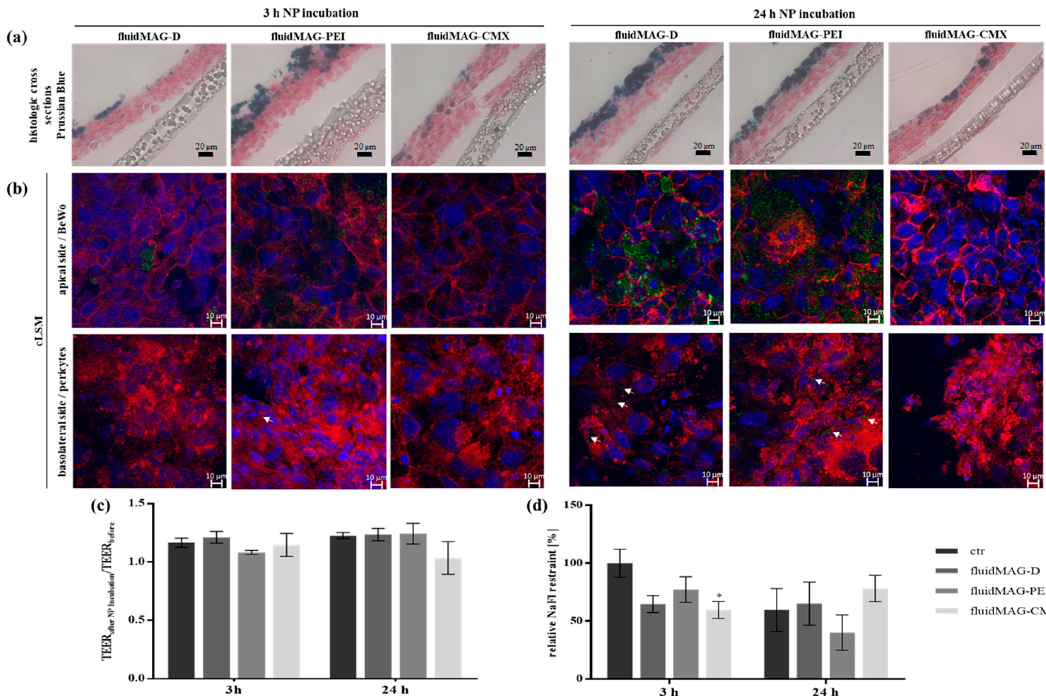
Figure 2. Analysis of the barrier integrity and morphology of the transwell co-culture BPB model after exposure to different SPIONs for 3 h or 24 h. For the co-culture model, 1.1 × 10 6 cells cm − 2 of pericytes were seeded onto the basolateral side of 24-well membrane inserts and 6.1 × 10 5 cells cm − 2 of BeWo cells were seeded on the apical side of the insert membrane after 24 h. On day four post seeding (PS), barrier models were exposed to 100 µ g cm − 2 (200 µ g mL − 1 ) of D/PEI/CMX-coated SPIONs for 3 h or 24 h. ( a ) After SPION exposure, histologic cross sections of cell grown transwell membranes were prepared and stained with Nuclear Fast Red and Prussian blue. Scale bars represent 20 µ m. ( b ) For the analysis by confocal laser scanning microscopy (cLSM) samples incubated with fluorescently labeled SPIONs (green) were fixed and stained with Hoechst 33258 (blue) and Alexa Fluor ® 633 phalloidin (red). White arrows mark SPION aggregates in pericyte cell layer. Scale bars represent 10 µ m. ( c ) Transepithelial electrical resistance (TEER) values measured in triplicates per insert before and after SPION exposure were compared for each condition. Shown are the mean values of the quotient of measured TEER values before/after SPION incubation ± standard deviation of three independent experiments. ( d ) The passage of the permeability marker sodium fluorescein (NaFlu) through the barrier after SPION incubation was measured in duplicates for each condition and the calculated permeability coefficients were normalized to blank membranes. Shown are mean values of the x-fold NaFlu retention ± standard deviation of three independent experiments. The significance of the results compared to respective control measurements without SPIONs was tested using two-way analysis of variance (ANOVA) following Tukey’s multiple comparison test. Statistically significant differences are depicted as: * p < 0.05. The corresponding p values for the comparison of all data sets for ( c , d ) are listed in Tables S2 and S3, respectively.